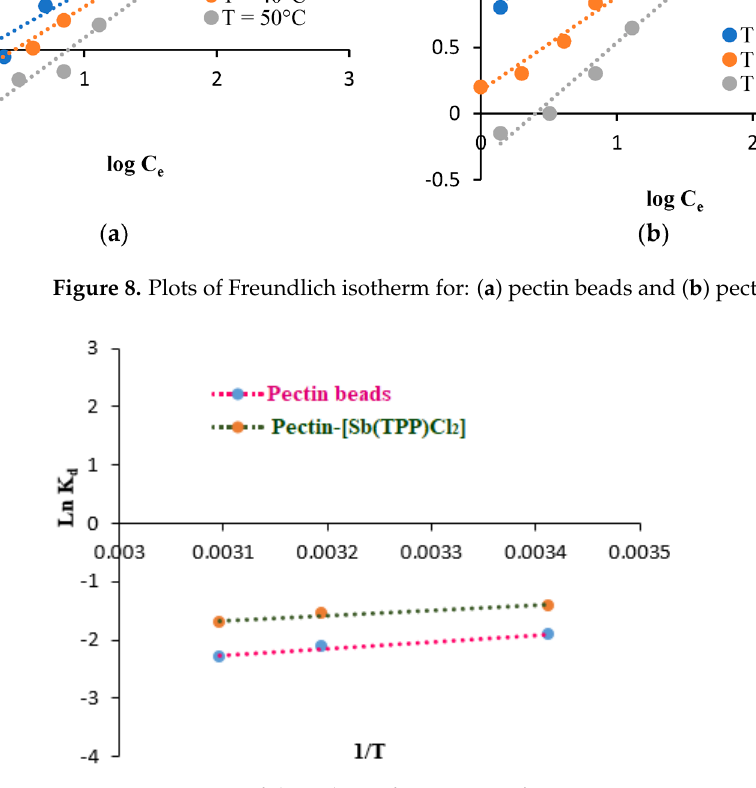
Figure 9. Variation of the values of Ln K d vs. 1/T. Table 5. Thermodynamic constants calculated for methylene blue removal using pectin beads, and pectin-[Sb(TPP)Cl 2 ] beads